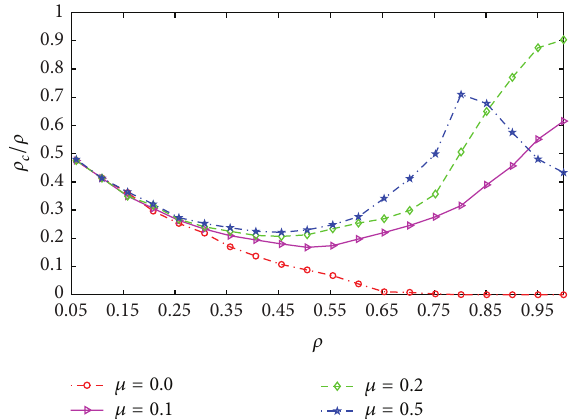
Figure 3: Relative density of cooperators 𝜌 𝑐 /𝜌 in dependence on the occupation fraction 𝜌 for the different fractions of A players 𝜇 when 𝛼 = 3.0 and 𝑏 = 1.15 (see legend). Irrespective of the values of 𝜇 , the relative fraction of cooperators decreases from around 0.47 with the increase of 𝜌 , and then the curves for different values of 𝜇 depart around 𝜌 = 0.1 . For 𝜇 = 0 , the relative density of cooperators decreases monotonically with the increase of 𝜌 until approaching zero. When 𝜇 is equal to 0.1 or 0.2, the relative density of cooperators decreases monotonically with the increase of 𝜌 until approaching its minimum value and then increases monotonically with the increase of 𝜌 until approaching its maximum value at 𝜌 = 1.0 . In contrast, when 𝜇 is equal to 0.5, the relative density of cooperators decreases monotonicallywiththeincreaseof 𝜌 untilapproachingitsminimum value, then increases monotonically with the increase of 𝜌 until approaching its maximum value at around 𝜌 = 0.8 , and finally sharp decreases with the increase of 𝜌 until approaching its minimum value at 𝜌 = 1.0